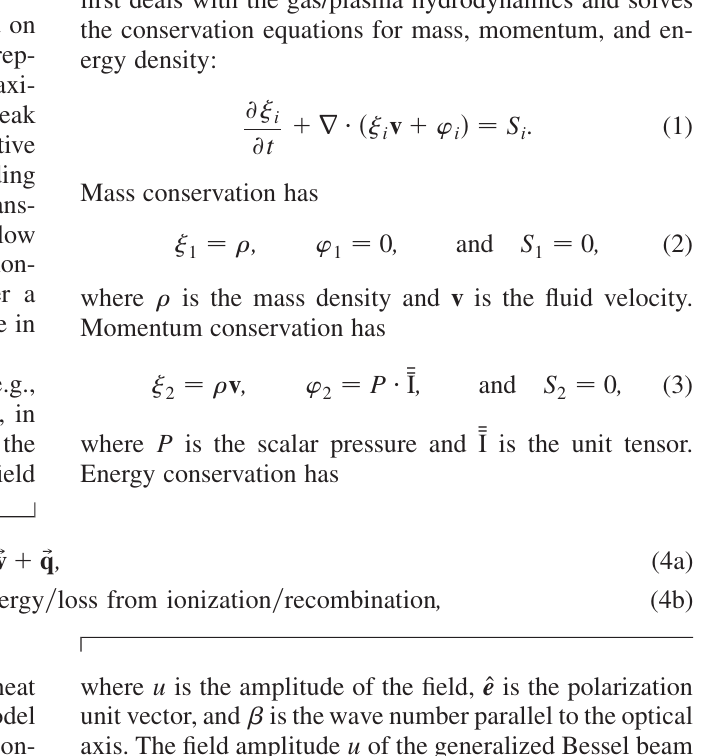
FIG. 3. (a) Electron density within the simulation box after 1 cm propagation of the drive bunch for r ch ¼ c=! 1 (cid:4) 10 16 cm (cid:1) 3 . (b) Longitudinal electric field on axis. The asterisks on the x axis indicate the locations of the drive and witness